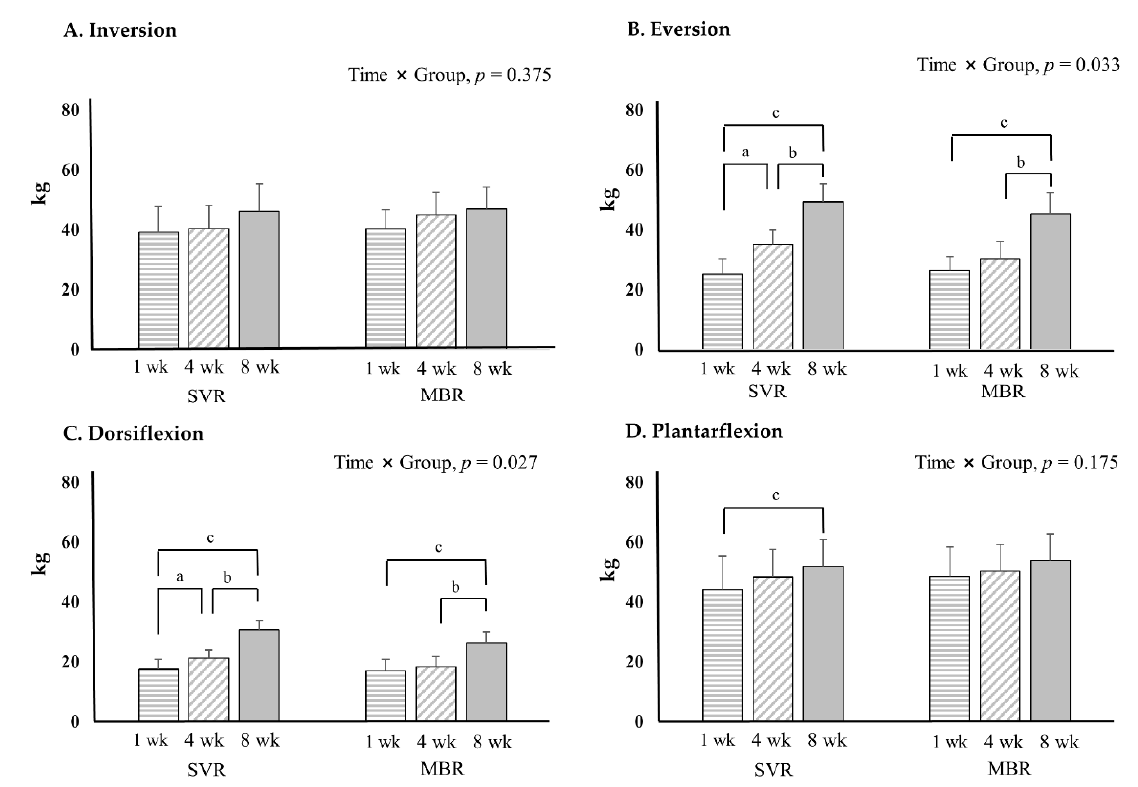
Figure 4. Ankle strength results with hand held dynamometer. p < 0.05; significance, a = 1 week versus 4 weeks; b = 4 weeks versus 8 weeks; c = 1 week versus 8 weeks. Abbreviations: SVR, supervised based rehabilitation; MBR, mobile-based rehabilitation, wk; week.